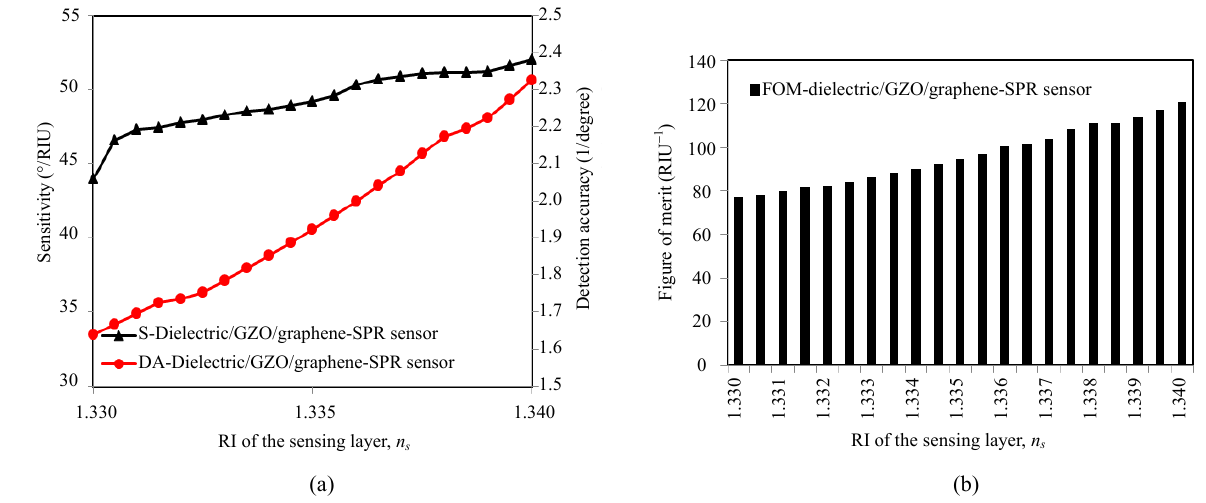
Fig. 8 Plot of (a) sensitivity and DA for the proposed SPR sensor and (b) FOM for GZO/graphene LRSPR sensor as a function of sensing layer RI (1.33 – 1.34) (thicknesses used for graphene, dielectric layer, and GZO are 0.34 nm, 2 000 nm, and 20 nm, respectively; RIs for the sensing medium and dielectric medium are n s = 1.33 – 1.34 and n d = 1.34,